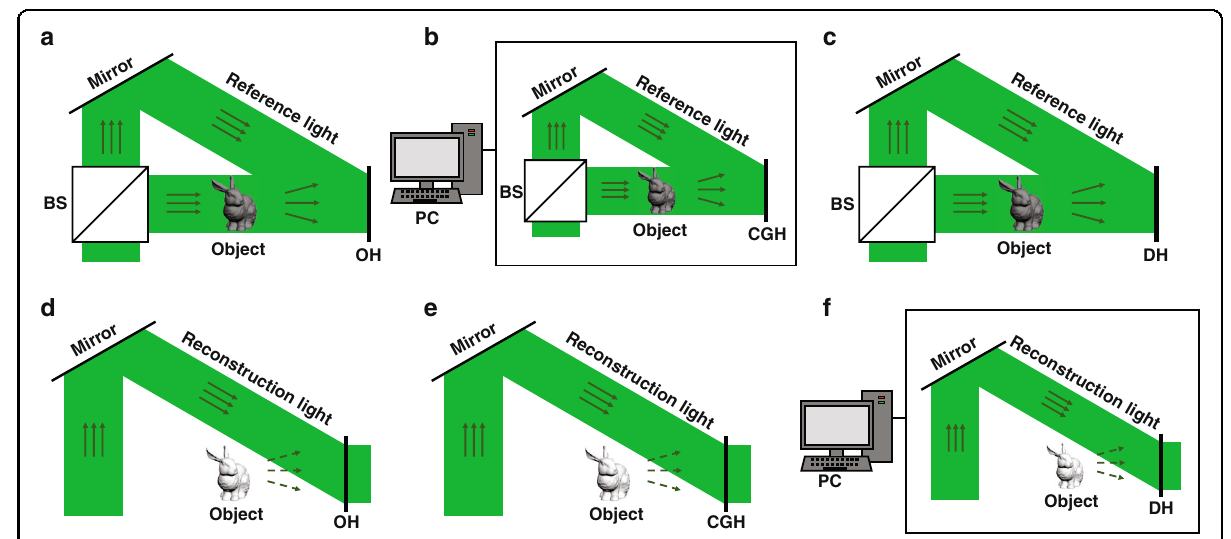
Fig. 2 The schematic of hologram recording and reconstruction process. a , d Optical holography; b , e computer generated holography; c , f digital holography, where BS is the beam splitter and PC is the personal